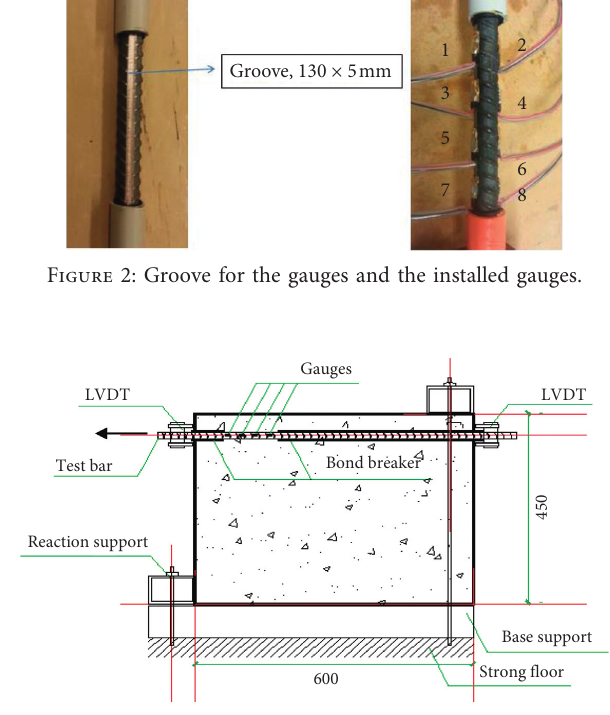
Figure 3: Schematic diagram of the beam-end